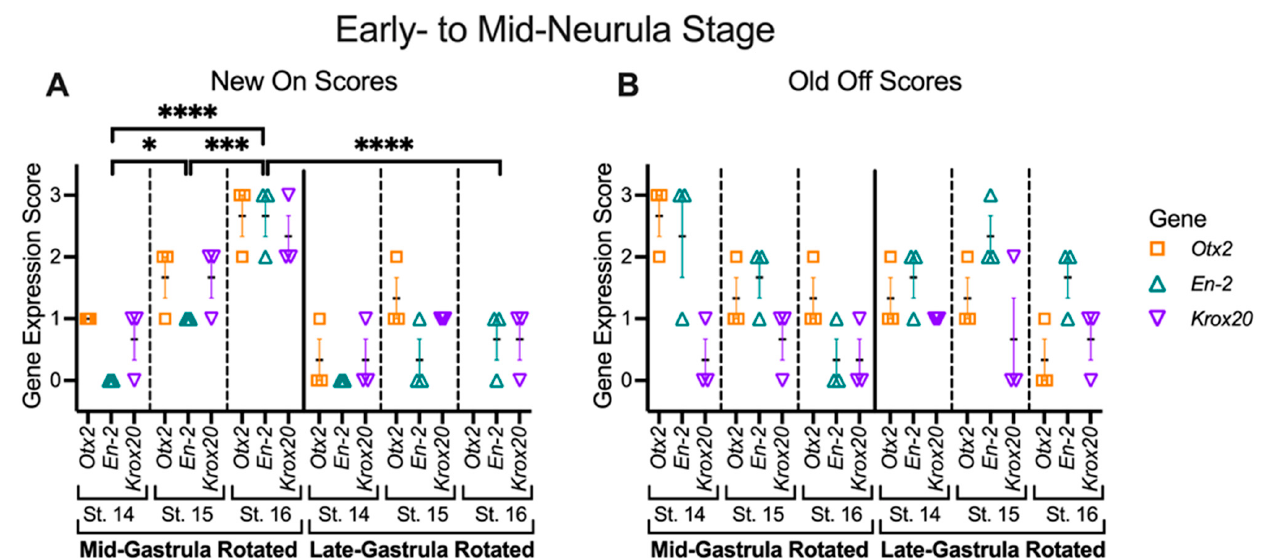
Figure 13. Histology scores for mid- and late gastrula rotated transplants at stage 14 to 16. Histological sections were scored for expression levels of regional marker genes, both correct “New On” expression ( A ) and ectopic “Old Off” expression ( B ). Horizontal black lines represent the mean, and error bars represent the SEM. * p < 0.05, *** p < 0.001, **** p < 0.0001. n = 3 for each stage and gene. For mid-gastrula rotated embryos, stage 15 embryos have significantly higher levels of correct marker gene expression than stage 14 embryos ( p = 0.0100), and stage 16 embryos have significantly higher levels of expression than both stage 14 ( p < 0.0001) and stage 15 ( p = 0.0007) embryos. Stage 16 mid-gastrula rotated embryos also have significantly higher levels of correct marker gene expression than stage 16 late gastrula rotated embryos ( p < 0.0001).